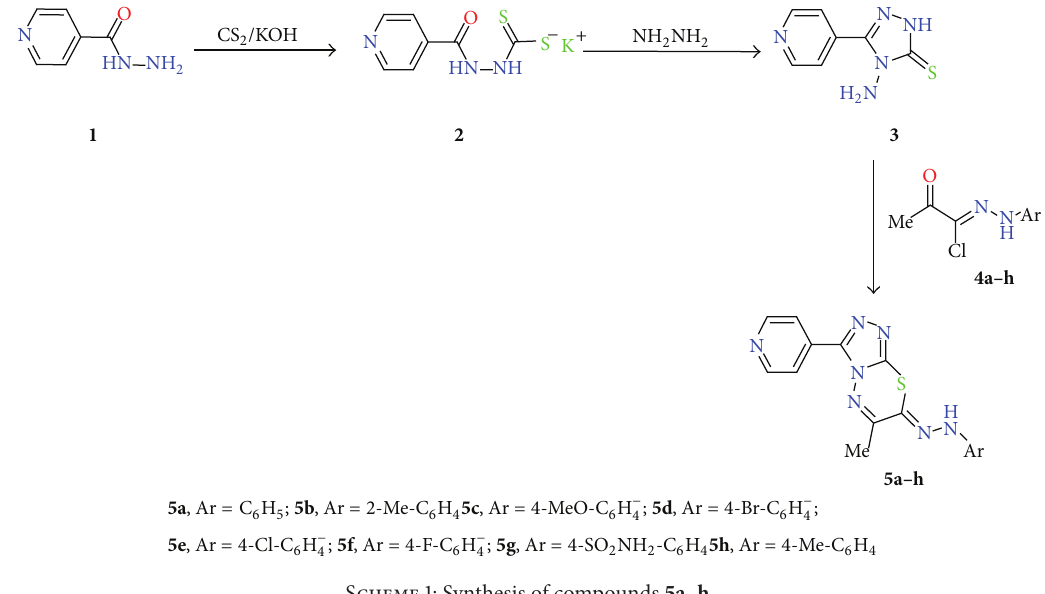
Scheme 1: Synthesis of compounds 5a–h